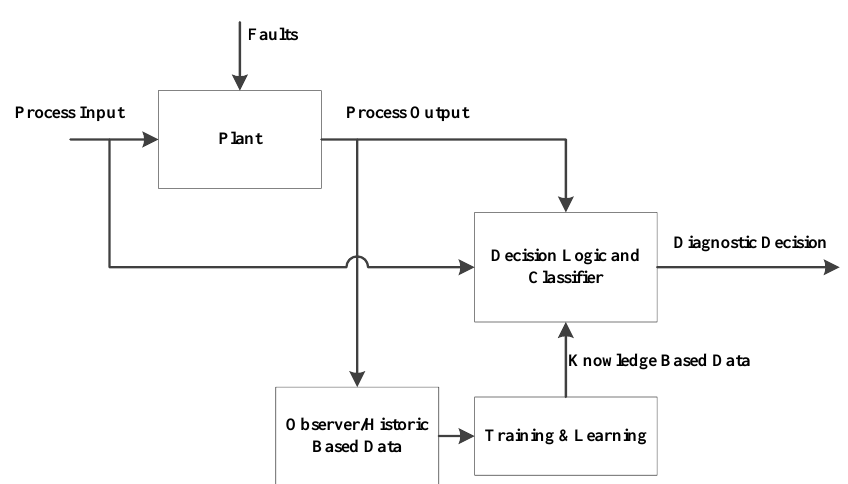
Figure 10. General structure of knowledge-based FDI